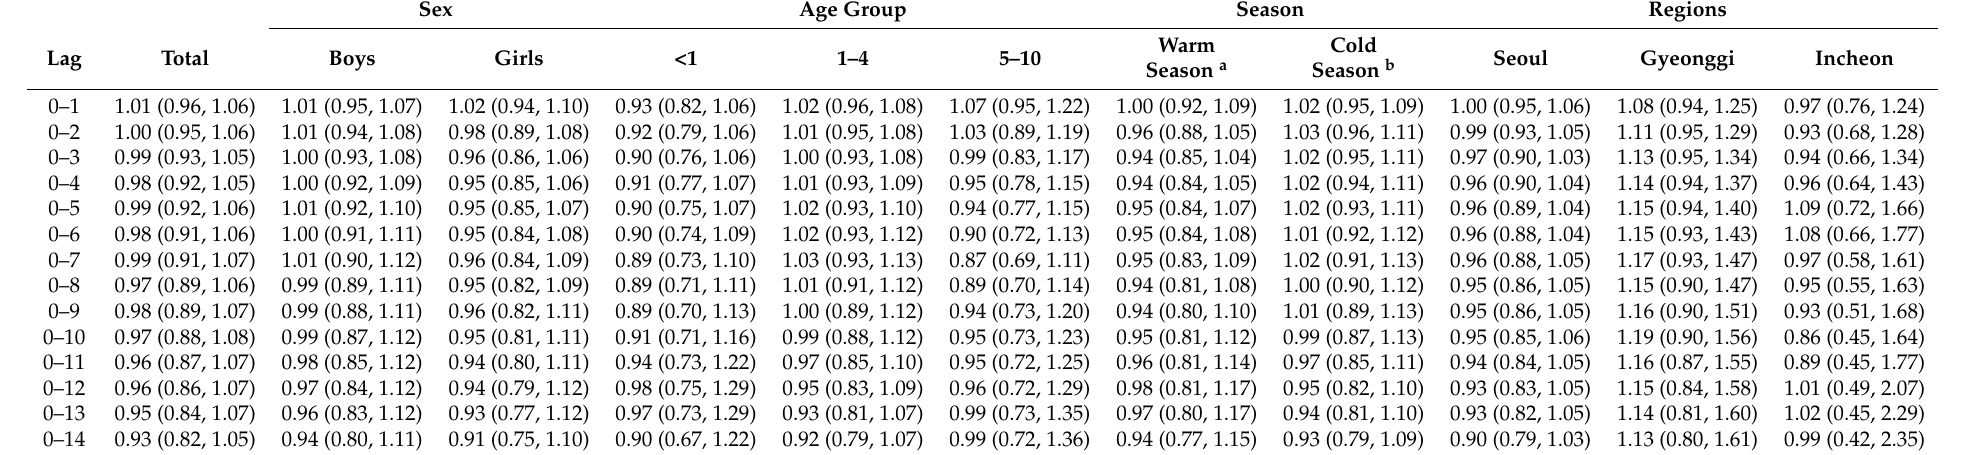
Table 3. The association between short-term exposure to PM 2.5 and children’s KD hospitalization, total and by sex, age group, season, and region. Sex Age Group Season